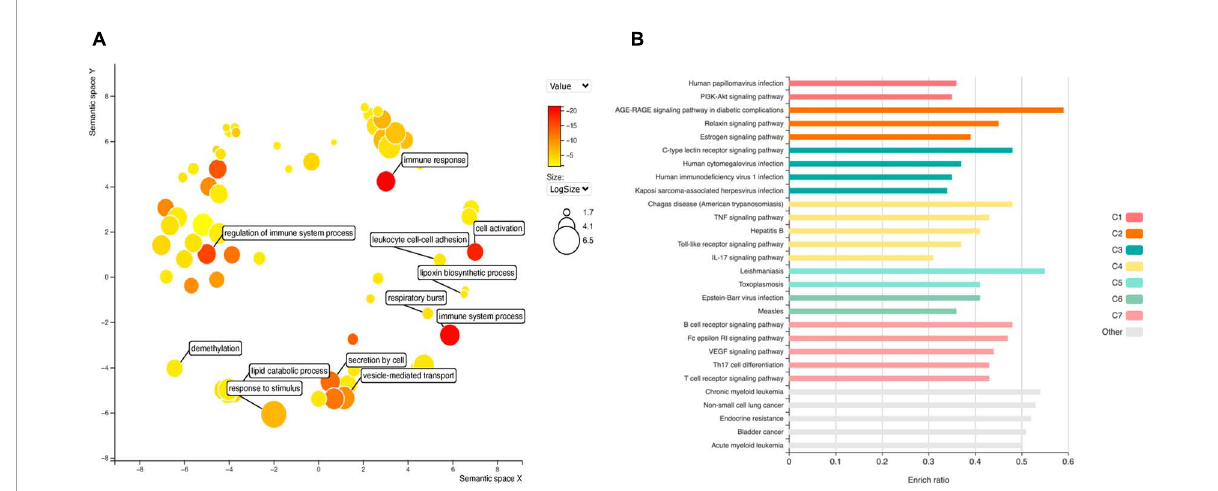
FIGURE4 Gene ontology (GO) analysis (A) for DEGs in EPCs. Color intensity represents adjusted p -value, circle size the number or genes. The main biological processes are depicted in the graph. Functional enrichment of KEGG terms (B) . Color represents clusters of DEGs and bar length the enrichment ratio.